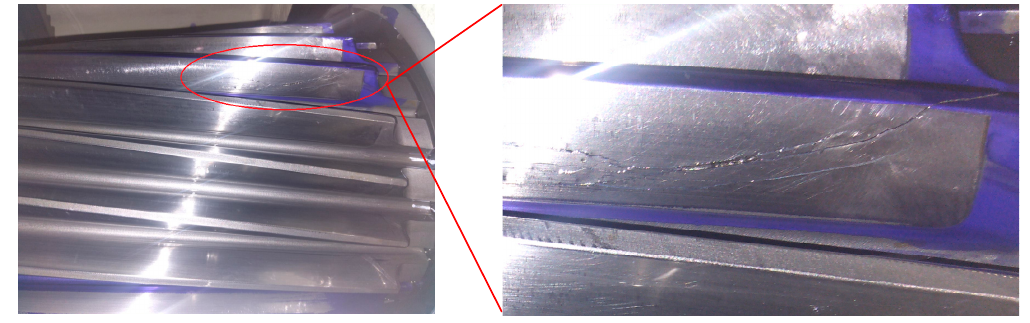
Figure 14. The photo of the gearbox fault.